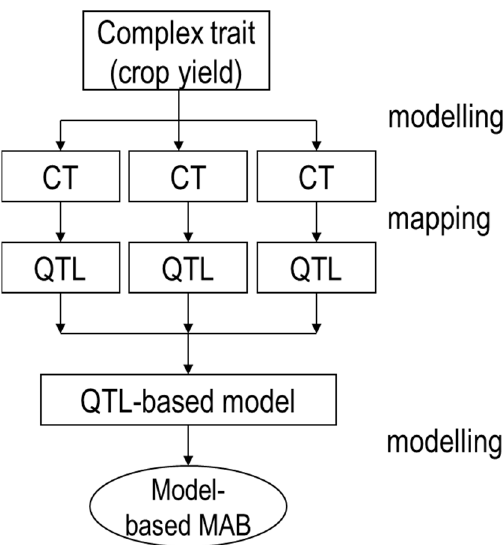
Figure 1. This is the scheme of quantitative trait locus (QTL)-based modelling approach. Photosyn- thesis and other traits are components that contribute to ‘crop yield’, and complex traits such as yield can also be dissected into component traits (CTs). CTs can be subjected to QTL analysis. With